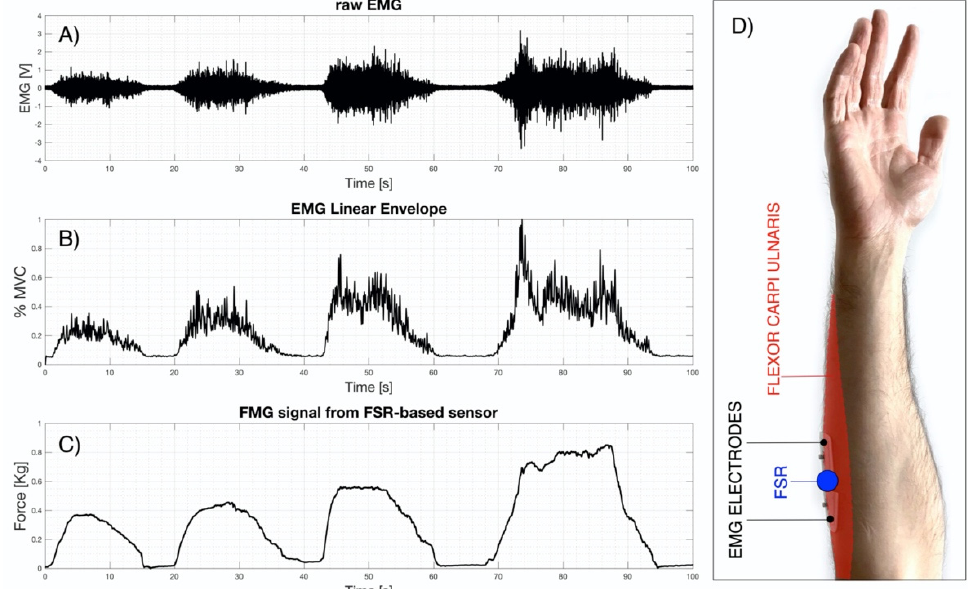
Figure 12. Simultaneous recordings from the forearm muscle “flexor carpi ulnaris”, while perform- ing four wrist flexion movements with increasing strength: ( A ) Raw EMG signal; ( B ) EMG linear envelope; ( C ) FMG signal from FSR–based sensor; ( D ) FSR–based sensor and EMG electrodes posi- tioned on the flexor carpi ulnaris of the subject’s forearm.